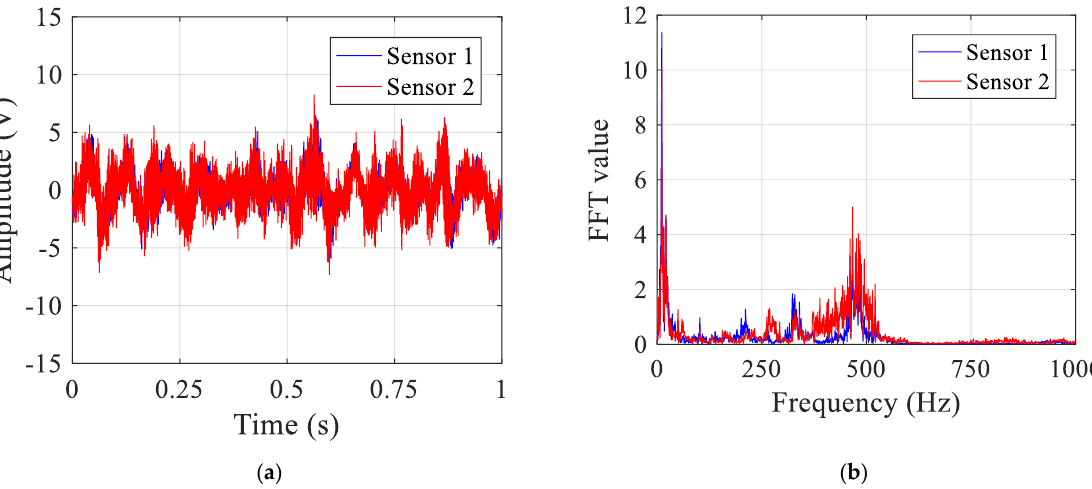
Figure 12. Test signals in the pipe with leakage: ( a ) in the time domain; and ( b ) in the frequency domain. The cross-correlation methods are now applied to sensor signals for leak localization.